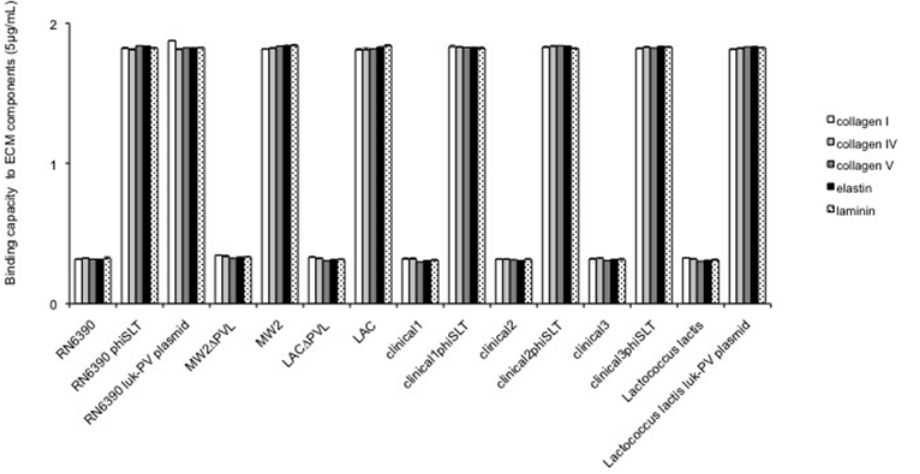
Figure 1. Binding capacity of isogenic strains from various genetic backgrounds to ECM components. Isogenic strains of Staphylococcus aureus and Lactococcus lactis examined for their binding capacity (Y-axis, absorbance reading at 540 nm) to ECM proteins (Sigma) coated on 96-well plates, at concentrations of 5 m g/mL (identical results were obtained at concentrations of 50 m g/mL). Collagen I (white bars); collagen IV (grey bars); collagen V (dark grey bars); elastin (black bars), laminin (dotted bars). RN6390, ref agr1 strain, luk -PV negative; RN6390phiSLT, RN6390 lysogenized with phiSLT; RN6390 Luk-PV plasmid, RN6390 carrying a luk -PV plasmid; MW2 D PVL, MW2 deleted of the luk -PV operon; MW2 wild type ( luk -PV positive); LAC D PVL, LAC deleted of the luk -PV operon; LAC, LAC wild type ( luk -PV positive); clinical1, luk -PV negative clinical strain from gut; clinical1phiSLT, clinical 1 lysogenized with phiSLT; clinical2, luk -PV negative clinical strain from furuncle; clinical2phiSLT, clinical2 lysogenized with phiSLT; clinical3, luk -PV negative clinical strain from pneumonia; clinical3phiSLT, clinical3 lysogenized with phiSLT; Lactococcus lactis , L. lactis ; Lactococcus lactis Luk-PV plasmid, L. lactis carrying a luk -PV plasmid. The vertical lines indicate the standard deviations.